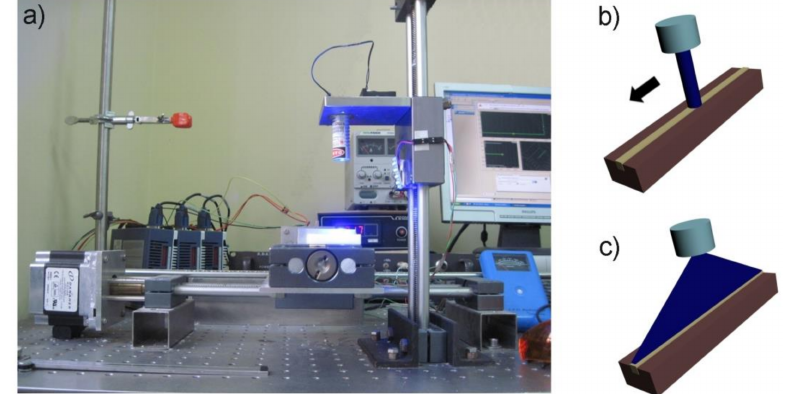
Figure 1. Set-up adopted for curing composite specimens. ( a ) CAD (computer-aided design)/CAM (computer-aided manufacturing) system used for positioning of the light beam of the LCUs; ( b ) Mode I curing. The relative movement at a constant speed between the LCU and the Teflon mould containing the composite material allowed to reproduce and standardise the photopolymerisation process; ( c ) Mode II curing. The laser and a cylindrical line generating lens were used to produce a line-shaped